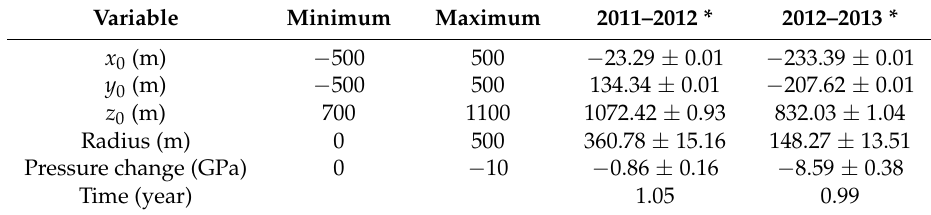
Table 1. Minimum, maximum, and optimized values of each unknown variable for constrained global optimization of the viscoelastic surface